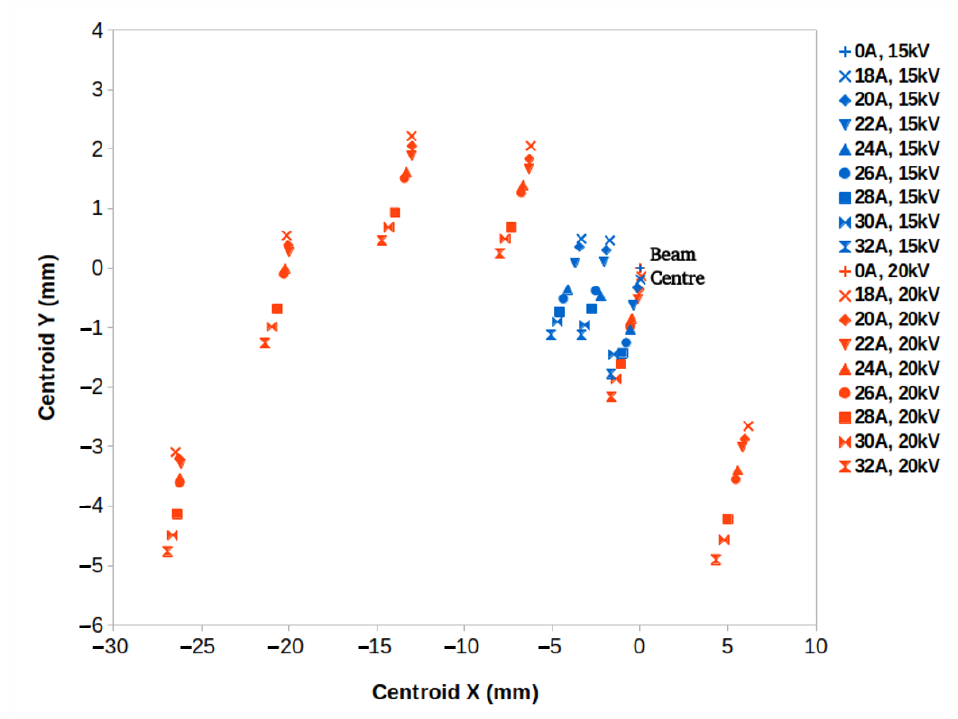
Figure 15. The x and y position of the centroids of the beam spots imaged with the Setup 1 (blue) and Setup 2 (red) with increasing magnetic field